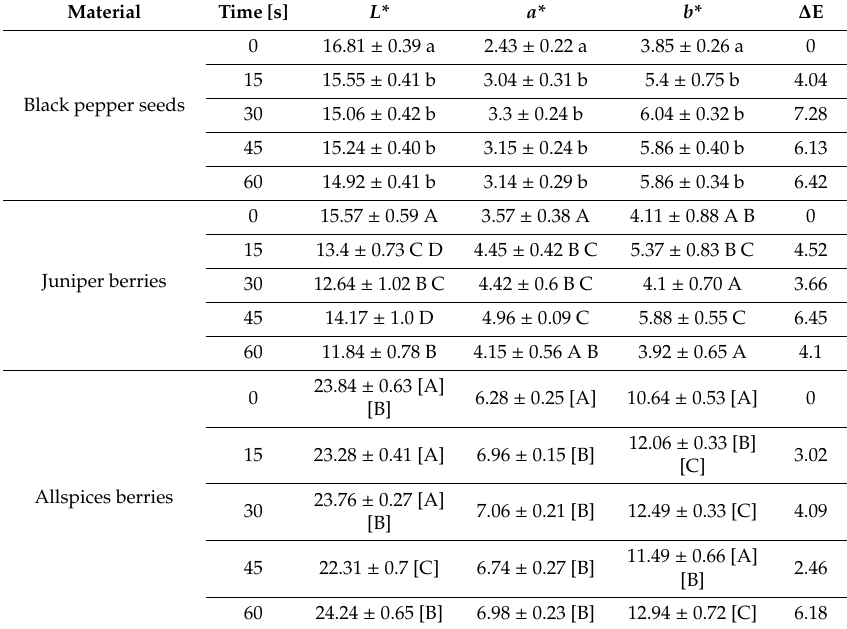
Table 1. The color of di ff erent spices subjected to plasma treatment. The same letters indicate homogenous groups ( α =